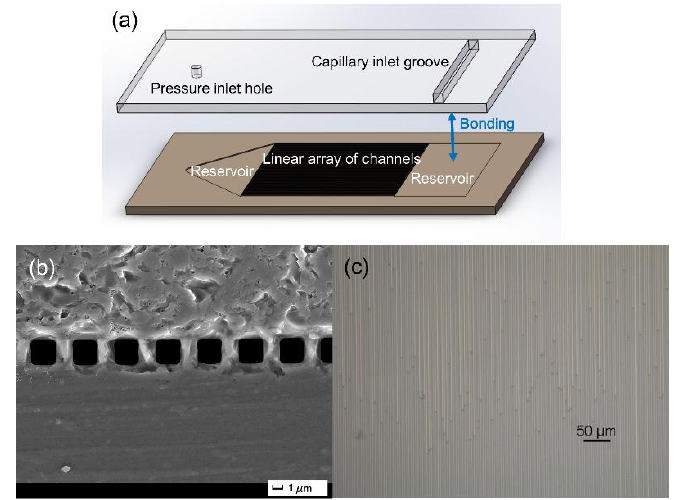
Figure 1. ( a ) An exploded view of the chip which is 38.5 mm long, 22.0 mm wide, and 1.0 mm thick. The channel array has an area of 16.0 × 16.0 mm 2 which is comparable to the size of the incident THz light spot. There are around 4,000 flow channels lying parallel between two reservoirs. ( b ) SEM end view of the 2.4 μm wide channels etched on the silicon substrate and bonded with the glass film. ( c ) Optical micrograph of top view of microchannels being injected with